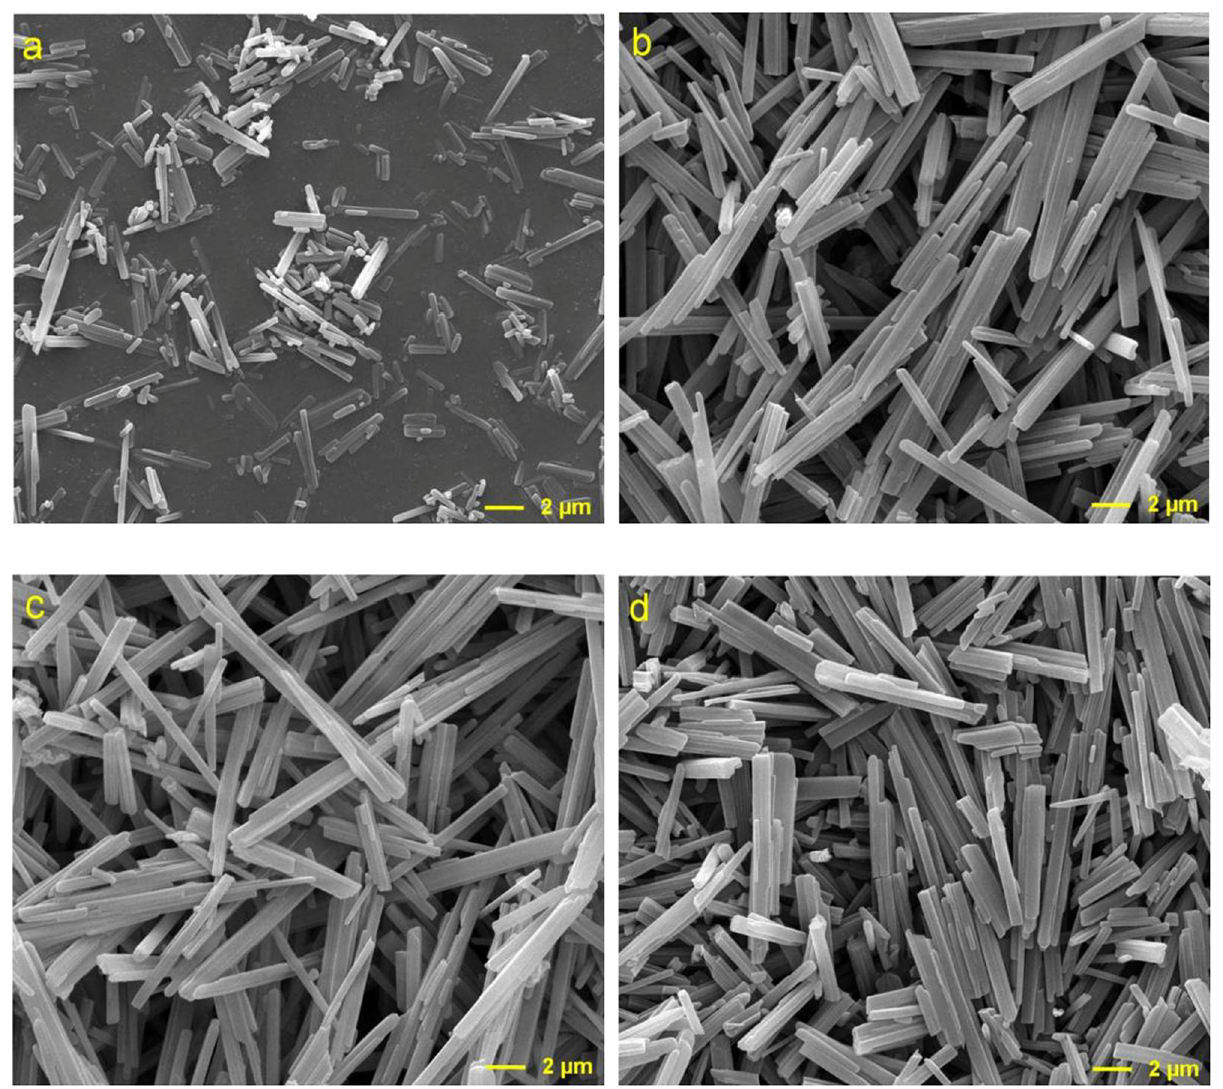
Figure 4: SEM images for the carbonation products from di ff erent carbonation times: ( a ) 30 min, ( b ) 60 min, ( c ) 90 min, and ( d ) 120